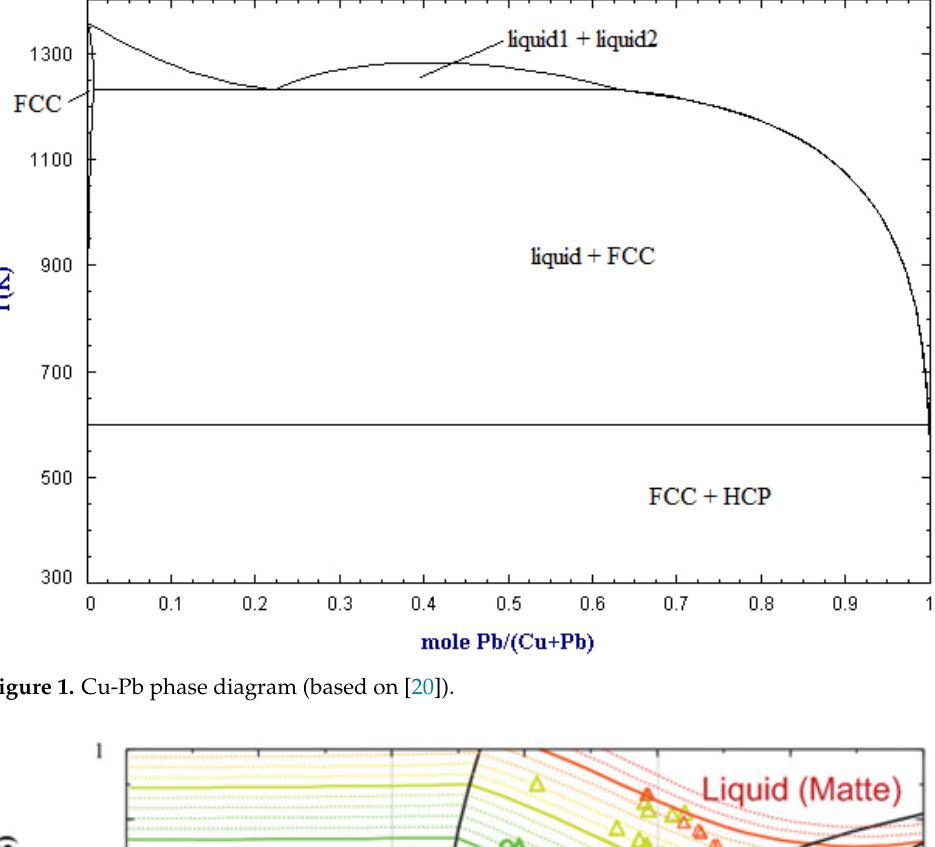
Figure 1. Cu-Pb phase diagram (based on [20]).